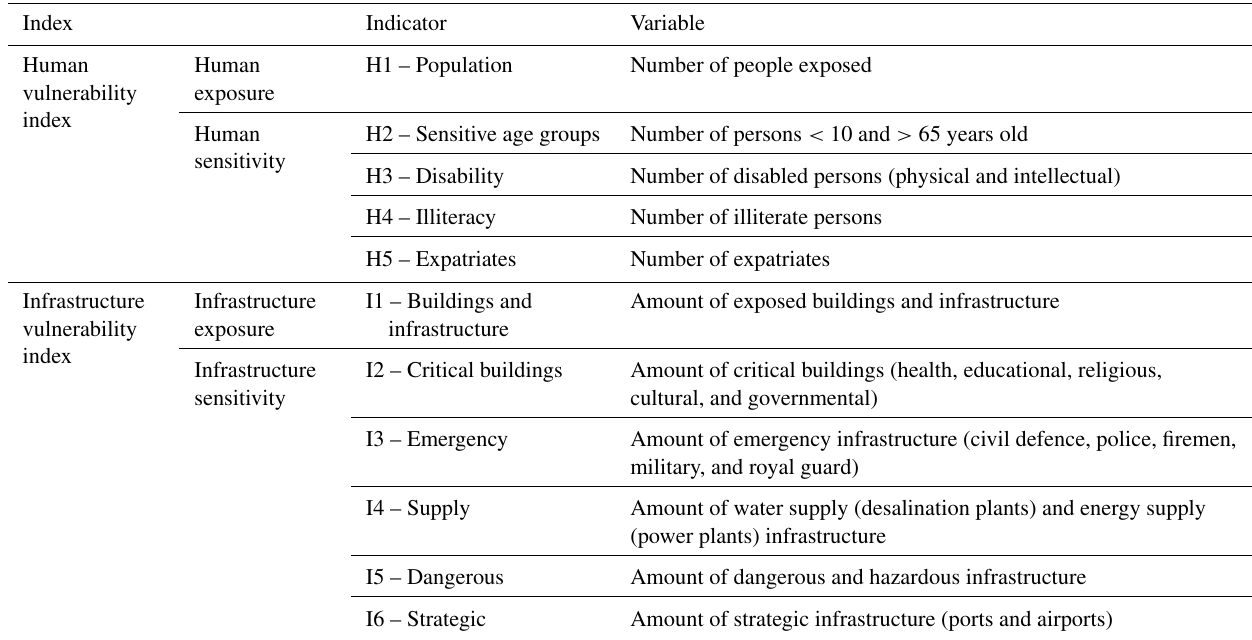
Table 1. Exposure and sensitivity indicators built for the tsunami vulnerability assessment in